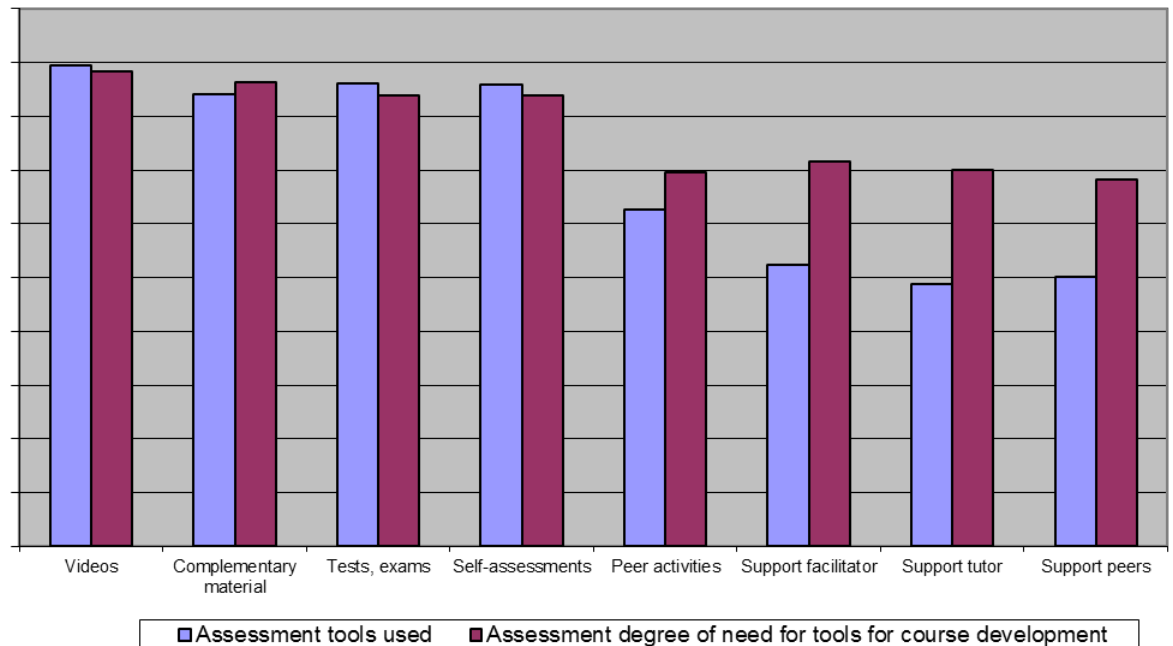
Figure 5. Assessment tools used and the degree of need for tools for course development